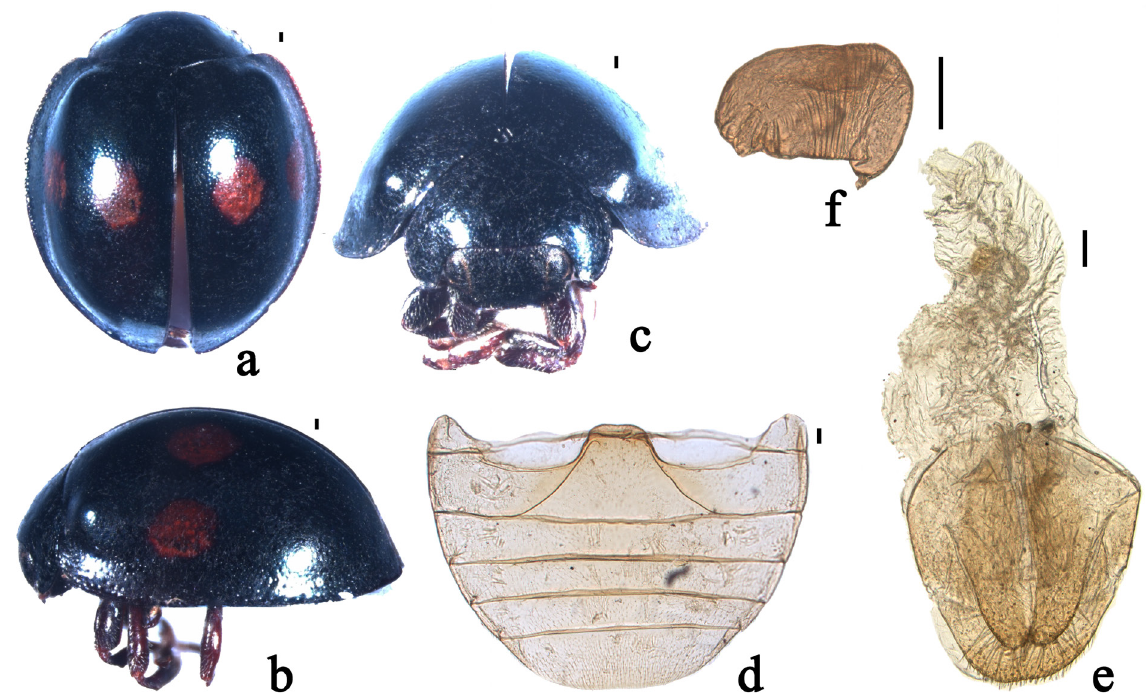
Fig. 17. Chilocorus alishanus Sasaji, 1968. a . Dorsal view. b . Lateral view. c . Frontal view. d . Abdomen. e–f . Female genitalia. e . Ovipositor. f . Spermatheca. Scale bars: 0.1 mm.